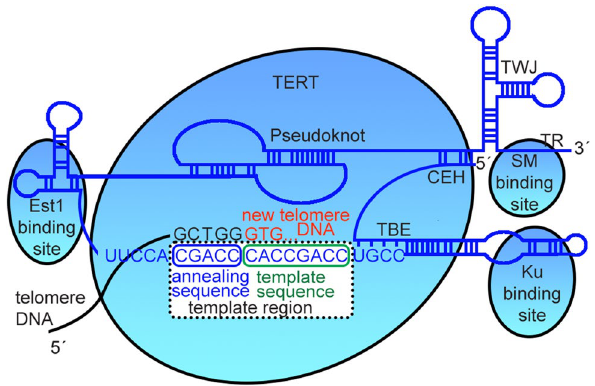
Figure 1. Telomerase RNA organization fo r Lachancea sp. The most relevant binding sites for protein-RNA interactions are indicated by blue ellipses (Est1, SM and KU), and the bigger one is the contact region with the reverse transcriptase (TERT). TBE template boundary element, TWJ three-way junction, CEH core enclosed helix. Adapted from Waldl et al. 36 The template region is located between the EST1 binding site and Ku binding hairpins. (Figure created using Adobe Photoshop